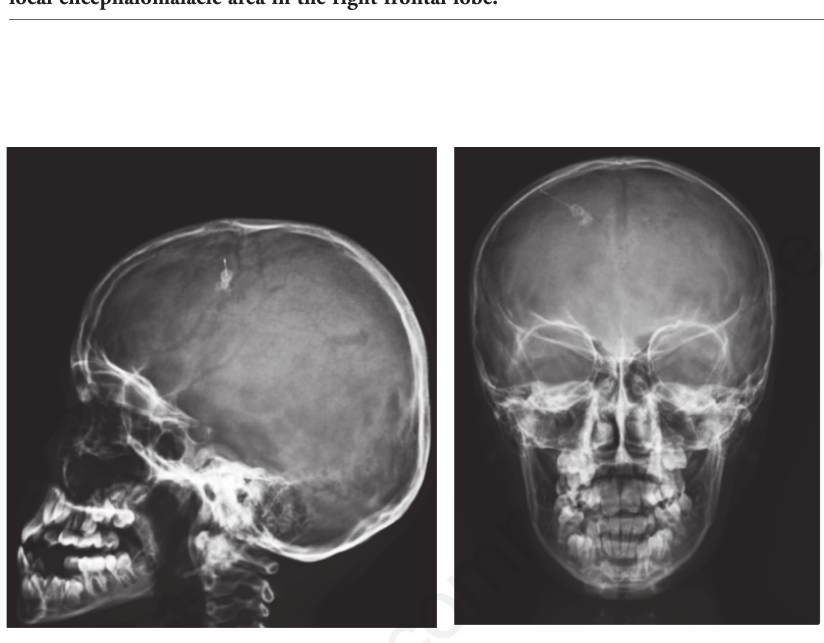
Figure 2. Transverse computed tomography images show the needle surrounded with a local encephalomalacic area in the right frontal lobe.